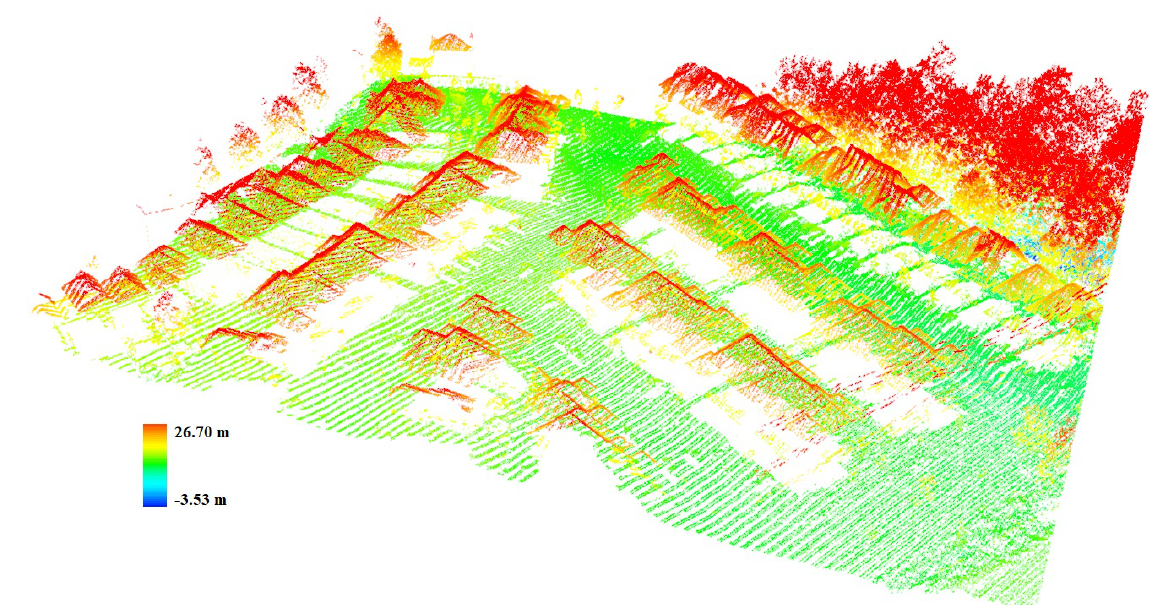
Figure 7. LiDAR (Light Detection and Ranging) data by height